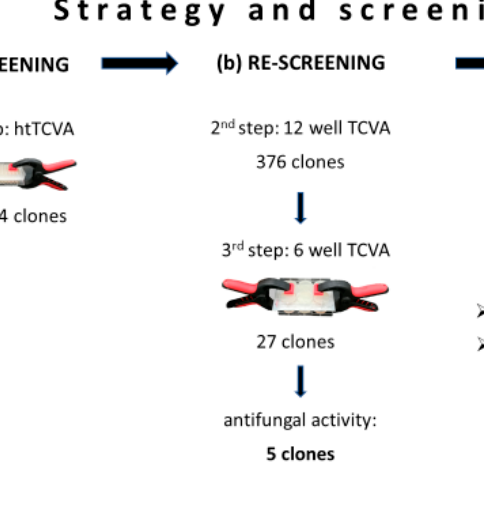
Figure 1. Schematic representation and results of the three-step screening process for antifungal volatile organic compounds (VOCs). ( a ) Initial step to identify metagenomic clones that emit antifungal VOCs employing the high-throughput Two Clamp VOCs Assay (htTCVA). ( b ) Two Clamp VOCs Assay (TCVA) as second and third step to confirm positive tested clones. ( c ) Evaluation of identified clones including the determination of the inhibition efficacy through the Petri Dish VOCs Assay (PDVA), and profiling VOCs to identify compounds of interest through headspace solid phase micro extraction gas chromatography-mass spectrometry (SPME GC-MS).